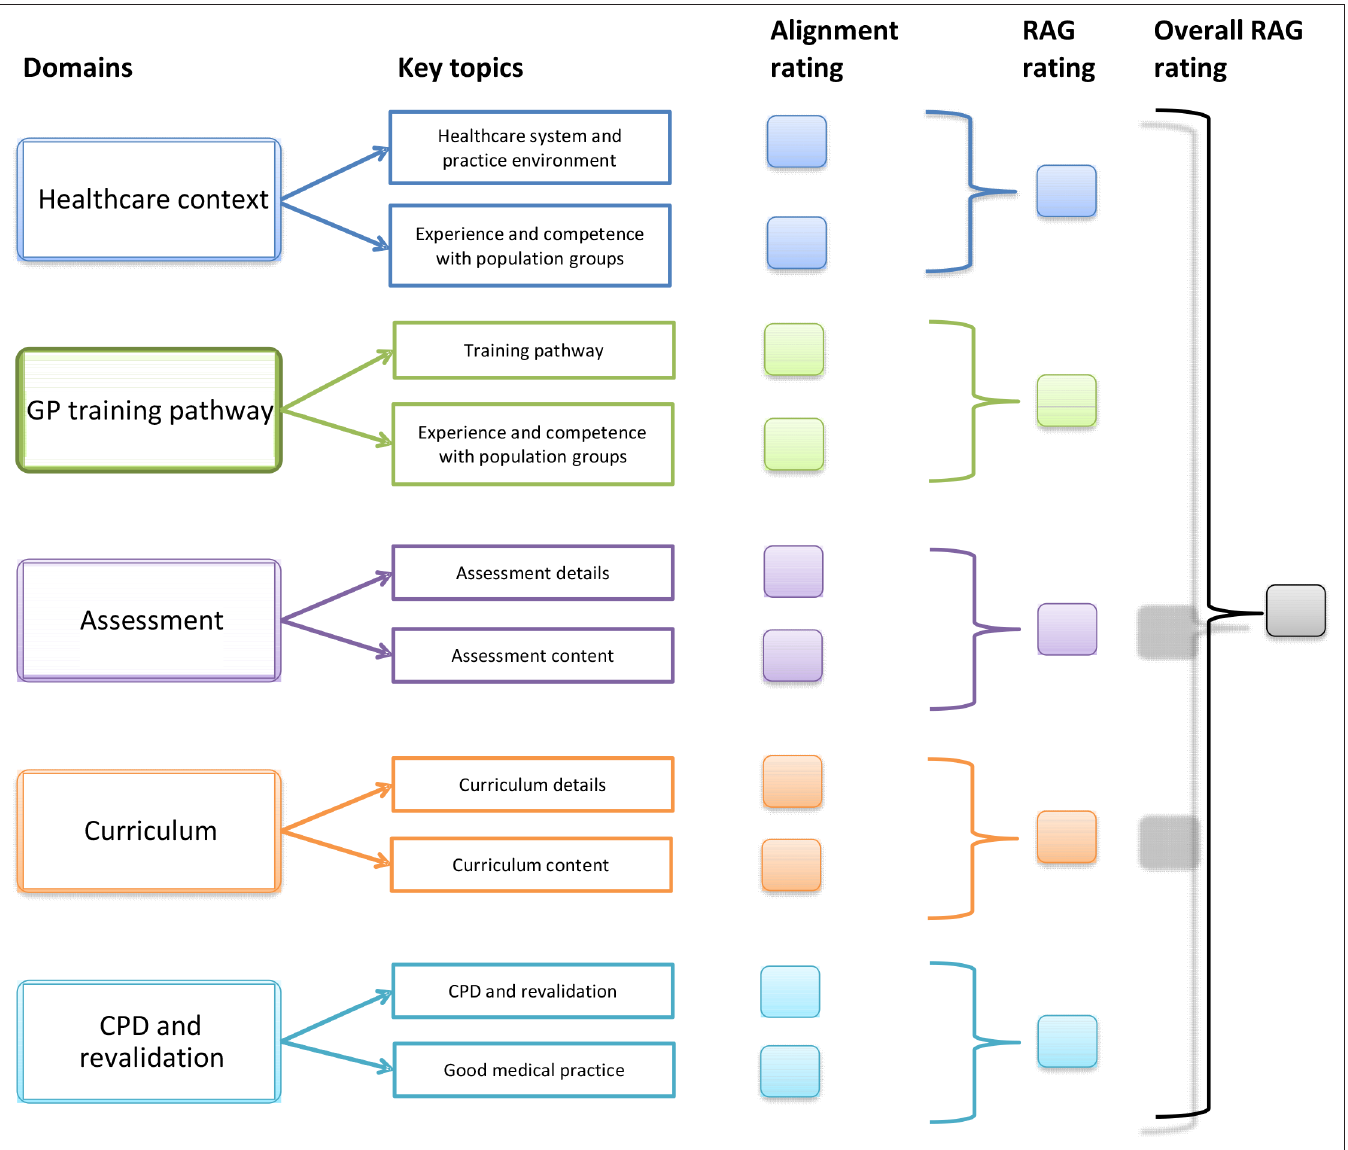
Figure 5 Structure and content of the proposed mapping framework (covering all five key domains) Colour coding indicates which key topics are contained within each of the five mapping